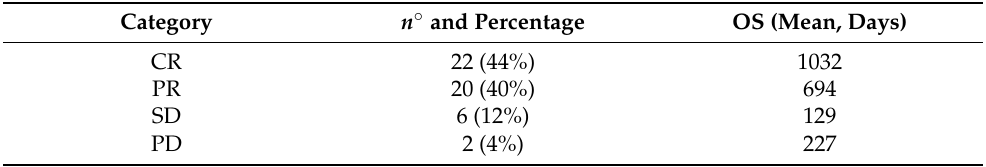
Table 2. TACE Treatment Response.